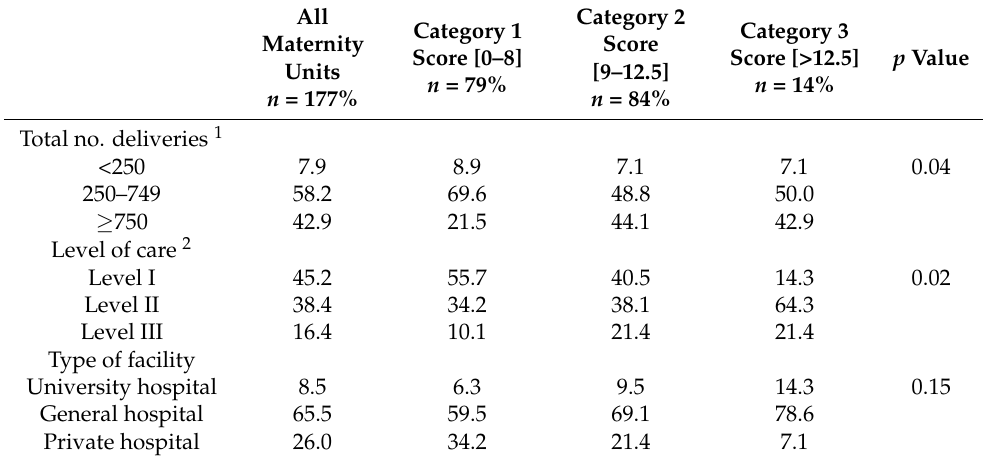
Table 1. Comparison of the characteristics of participating French maternity units overall and according to the protocol-quality